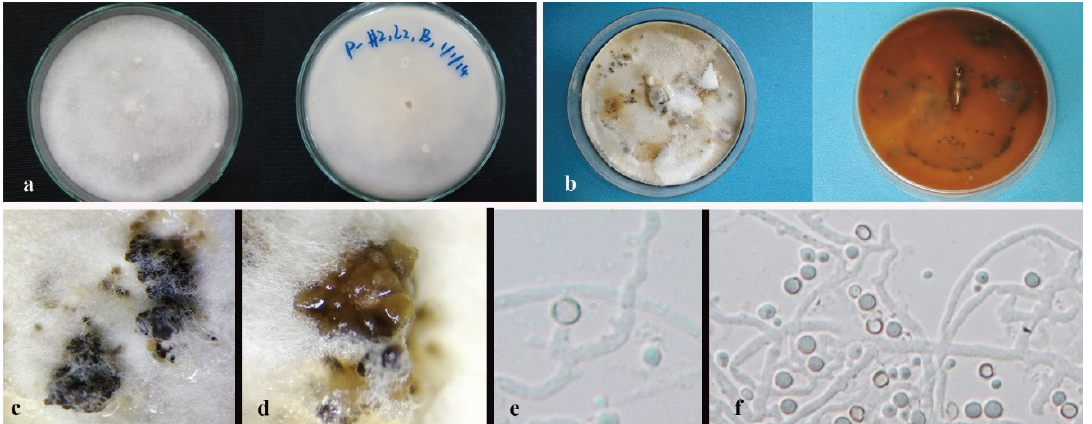
Figure 4. Nigrospora chinensis (MFLUCC 14–0109). ( a ) Colony on PDA (left-front view, right-reverse view). ( b ) Colony on MEA. ( c , d ) Conidiomatal masses. ( e ) Mycelia. ( f ) Conidia. Notes: ( c – f ) on 2%